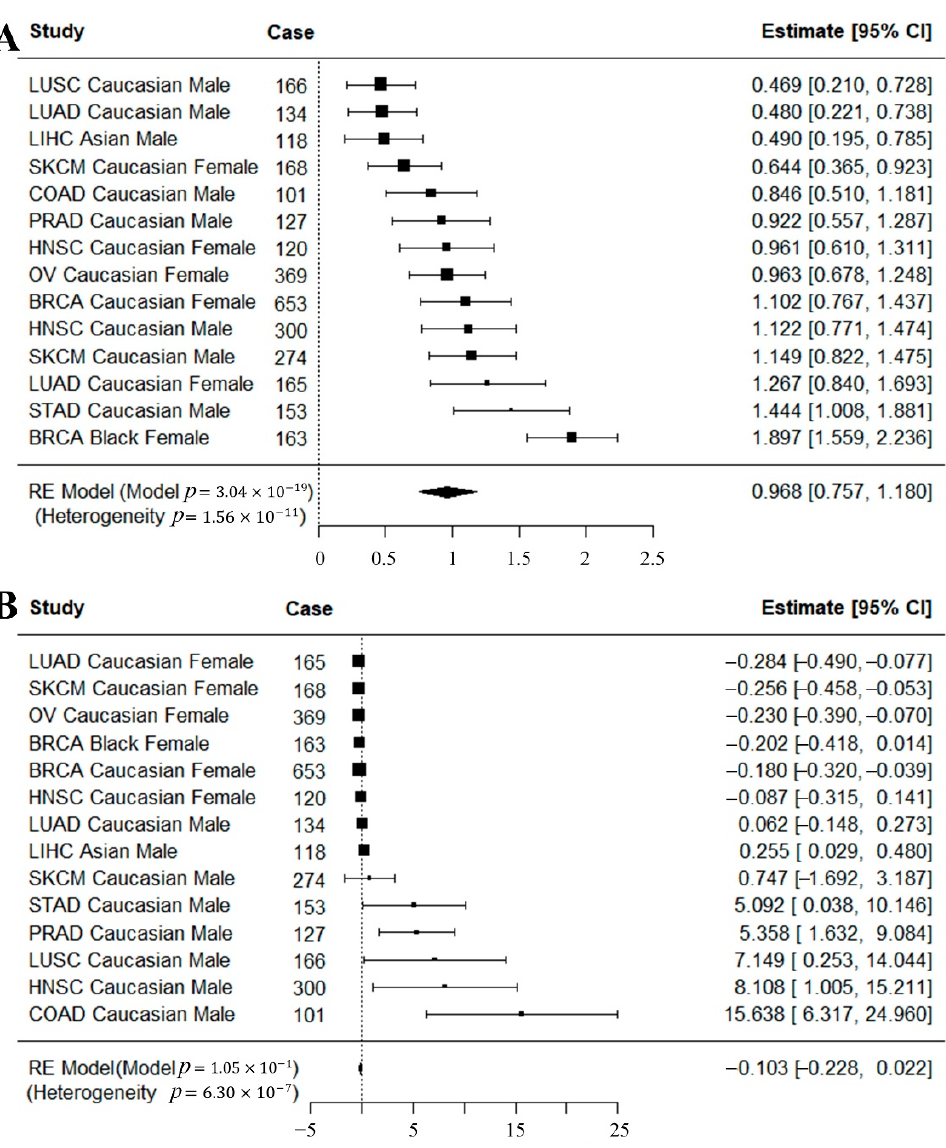
Figure 4. Meta-analysis for cancer risk. ( A ) Meta-analysis of cancer risk results of HR NonRef (Table 1). ( B ) Meta-analysis of cancer risk results of ROH (Table 2). Heterogeneity p < 0.05 indicates significant heterogeneity across cancer datasets, thus a random effect model was used for the meta-analysis. HR NonRef behaved consistently across multiple cancer types, which resulted in a significant meta-analysis p -value. ROH, on the other hand, was not significant.